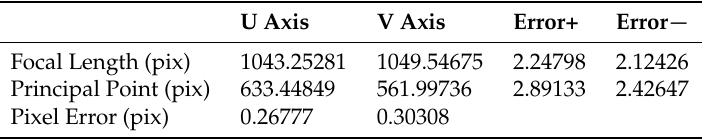
Figure 5. Calibration using checkerboard at different positions. Table 1. Intrinsic parameters of the right